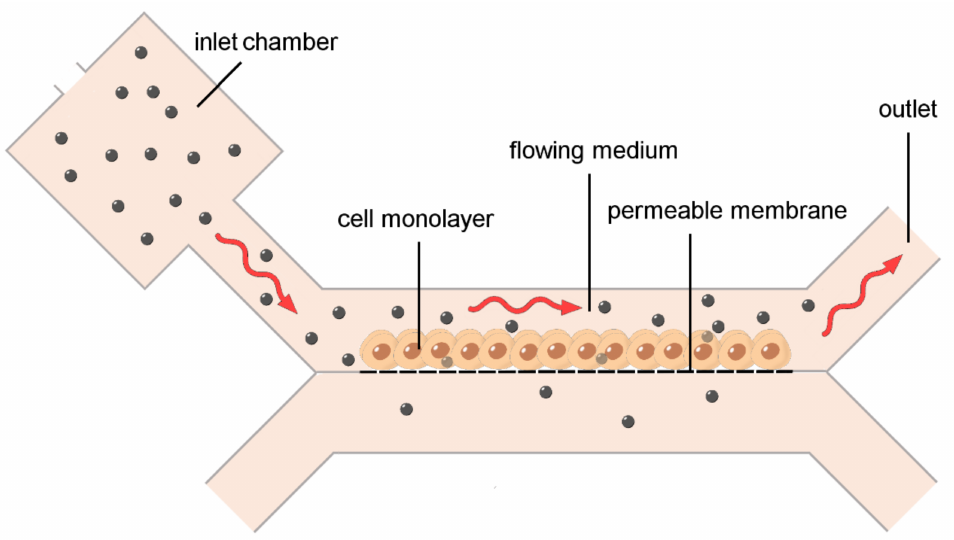
Figure 3. Schematic drawing of an in vitro barrier model under fluid dynamic conditions. Despite the high heterogeneity of devices described in the literature, the design is in principle the same for bioreactors and microfluidics. Nanoparticles are administered through the inlet chamber, move to the cells in the upper channel due to the flowing medium, and cross the cell monolayer toward the lower